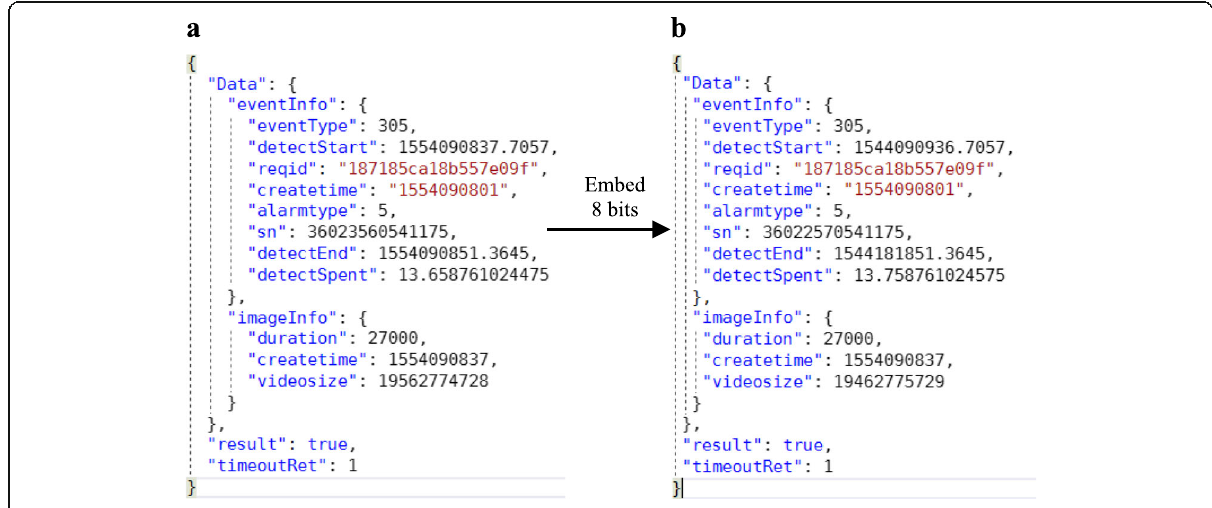
Fig. 7 Embedding test for a JSON file. a Cover data. b Stego data